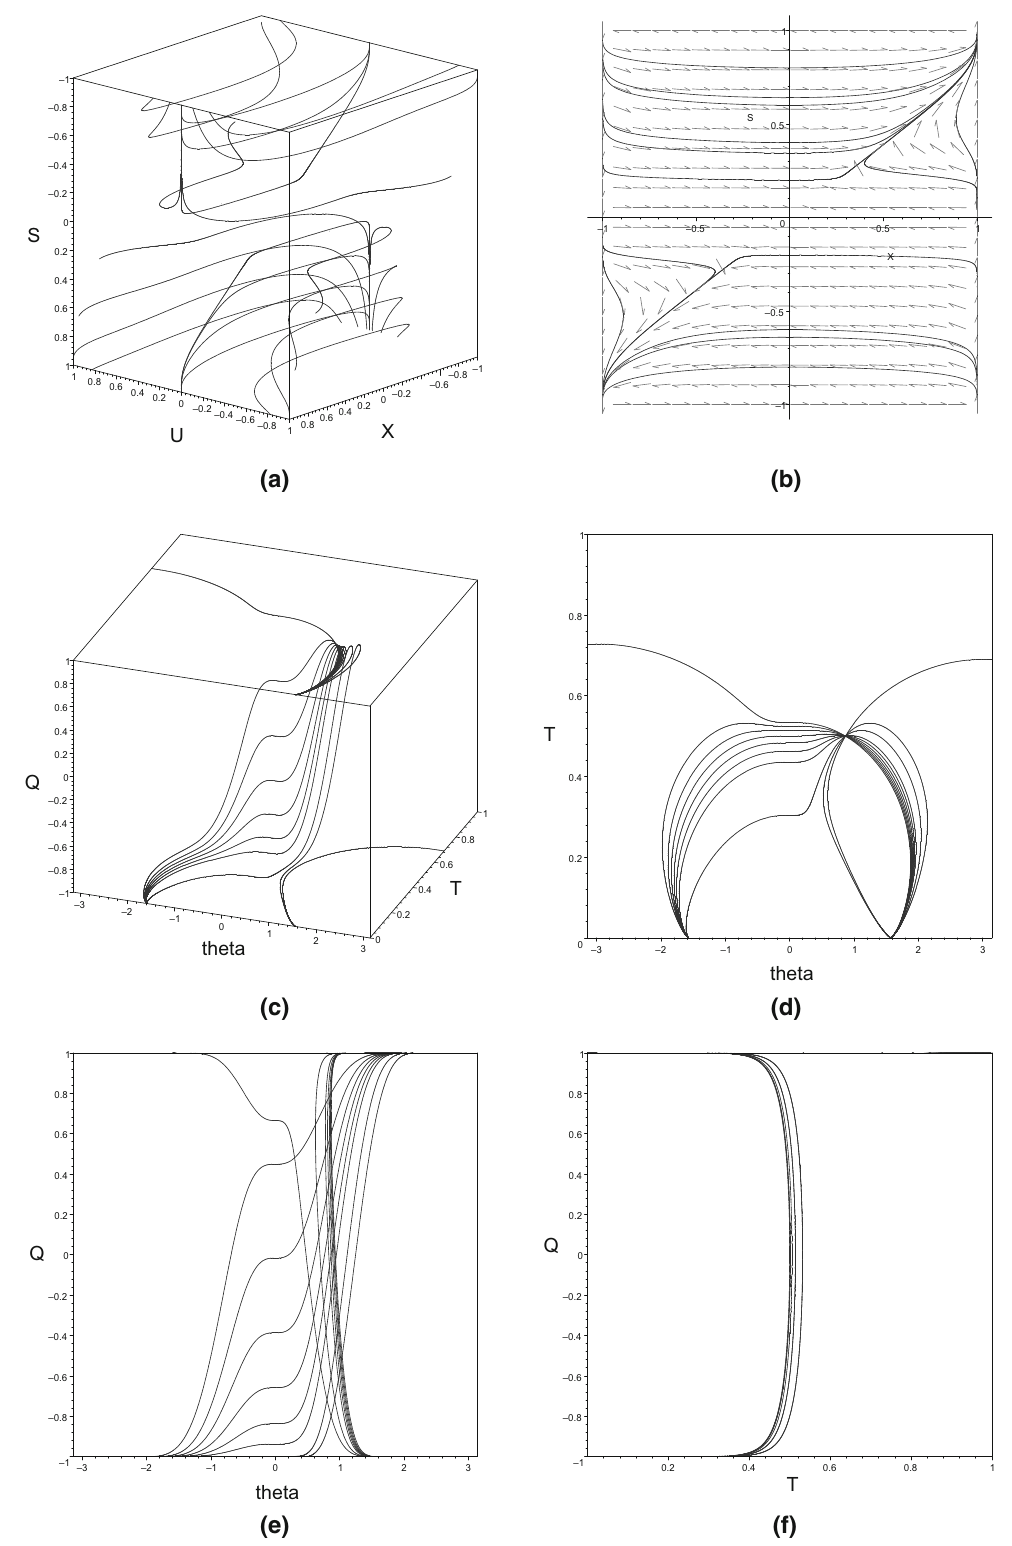
Fig. 8 a Compact phase portrait of (214), (215), (216) for the choice n = 2. b Dynamics in the invariant set U = 0. c – f Dynamics of (233), (234), (235), and some 2D projections of the solutions for n = 4 ,μ =